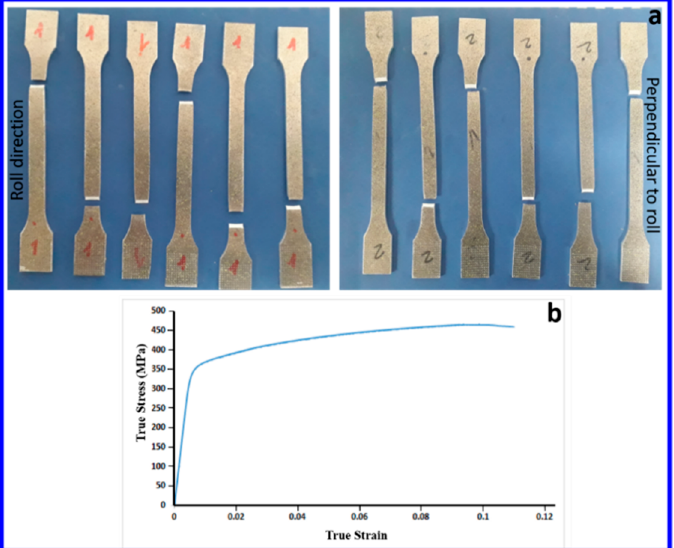
Figure 10. ( a ) Tensile test samples after failure; ( b ) mean stress–strain curve of aluminum alloy 2024-T3.